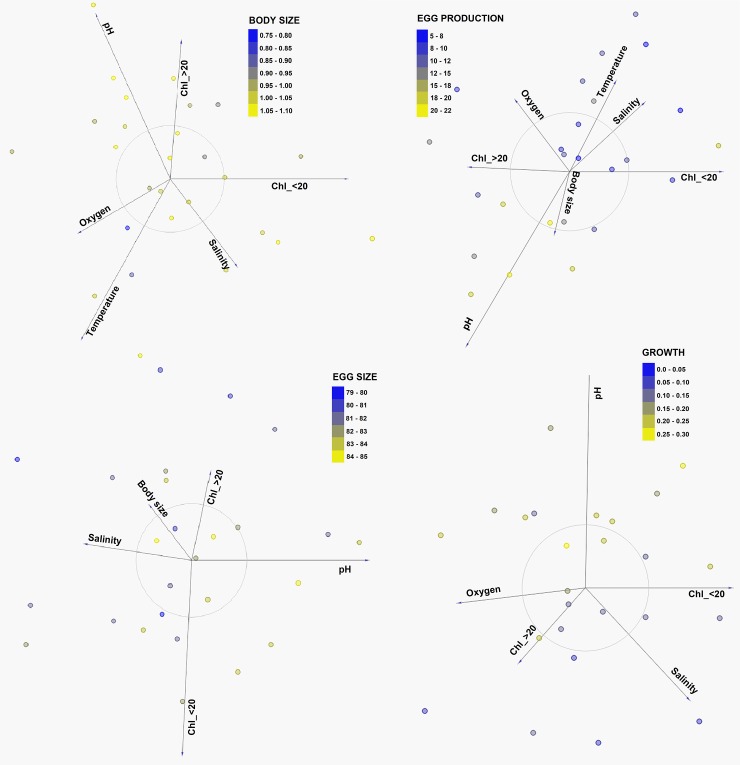
Different copepod responses modulated by the upwelling.Three-dimensional ordination of copepod traits (body size, egg production, egg size and growth) with regards to environmental factors after a LDA test was applied. Total explained was 61% (body size), 56% (egg production), 49% (egg size) and 60% (growth).